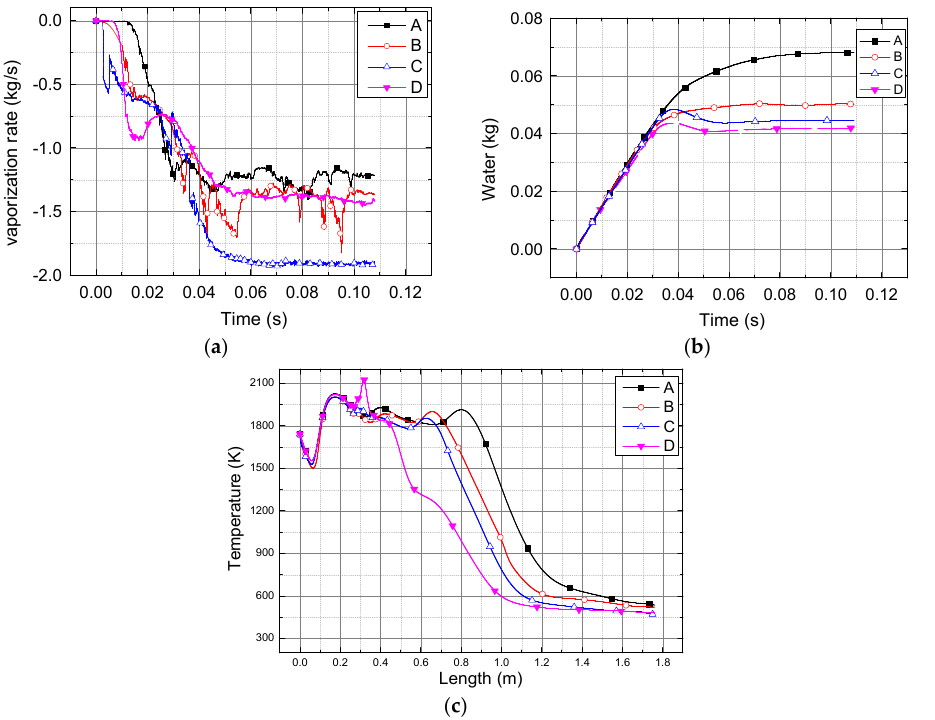
Figure 14. ( a ) Vaporization rate; ( b ) Mass of the remaining water; ( c ) Temperature of axial gas stream.